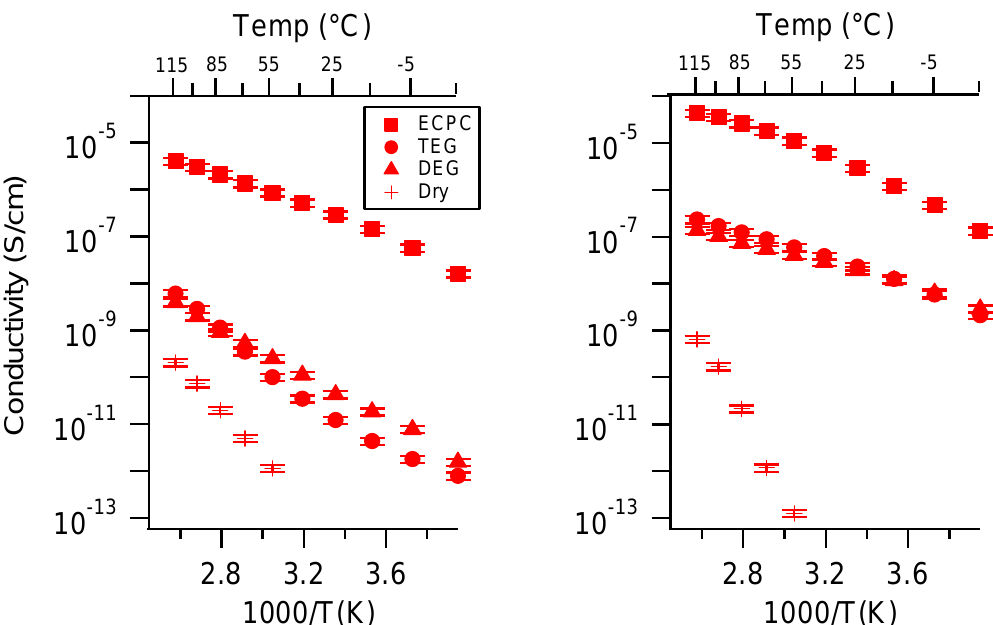
Figure A28. Conductivity as a function of solvent for PEGDMA1000_med_SSCa (left) and PTHFDA1000_med_STFSICa (right) SIPEs. Temperatures ranged from − 20 °C to 115 °C. Note that there may be a non ‐ negligible fraction of electronic conductivity in conditions where conductivity of less than 10 − 9 S/cm is reported.